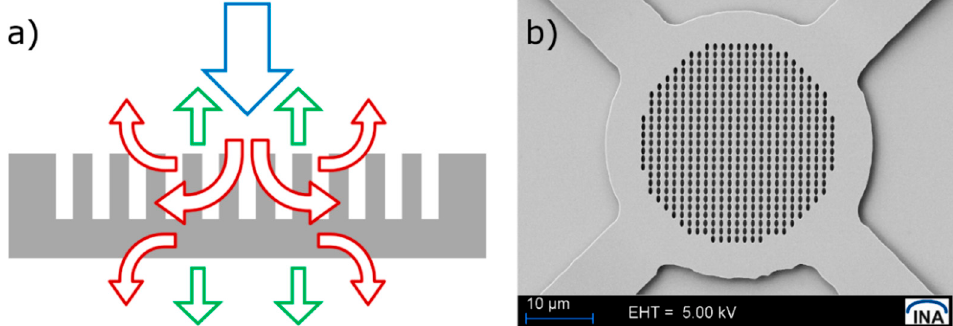
Figure 22. ( a ) Principle of a guided mode resonance. The incident wave (blue) is partly transmitted and reflected in form of continuous modes (green) and partly couples in and out the slab in form of a resonant mode (red). Superposition of both parts leads to the typical Fano line shape. ( b ) A MEMS membrane with elliptical air holes as base elements in a 2D square lattice, breaking the symmetry and leading to polarization dependent reflection and